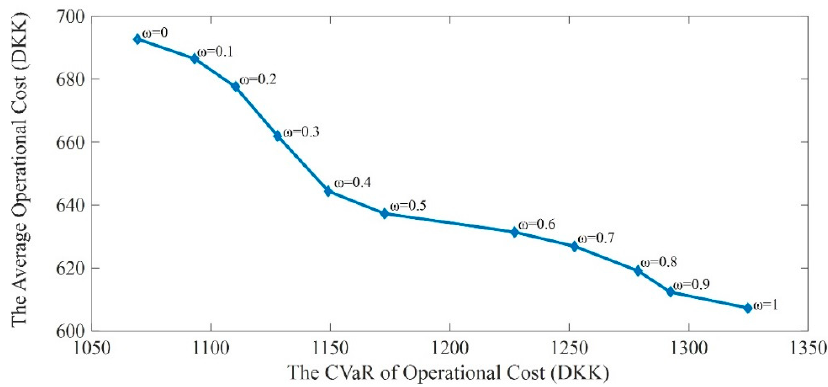
Figure 11. A Pareto efficient frontier between CCHP micro-grid’s obtained AOC s and COC s as 𝜔 increases.